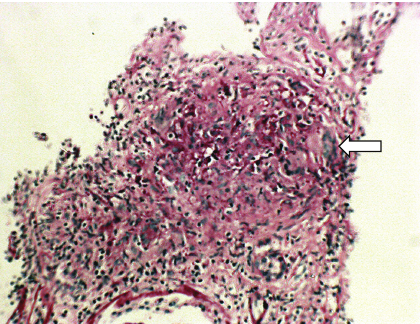
Figure 1: High-power haematoxylin- and eosin-stained renal bio- psy before antituberculous treatment demonstrates the presence of a granuloma with caseating central necrosis (white arrow).